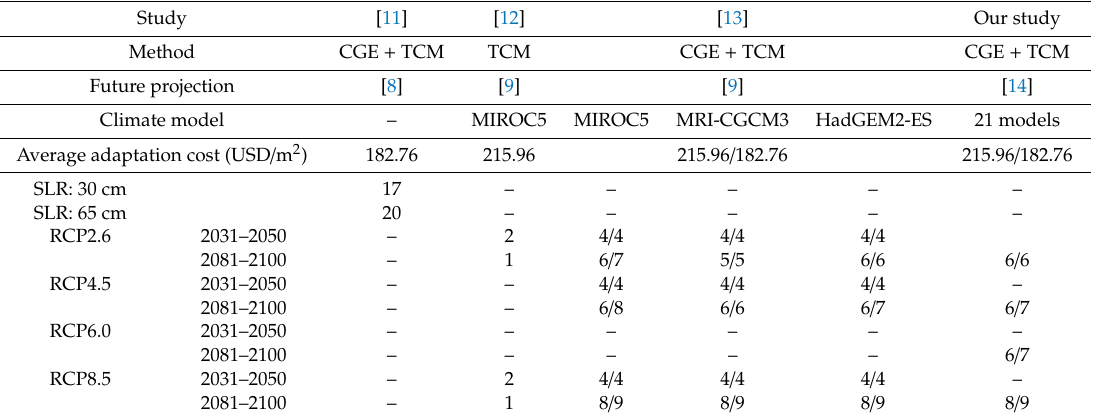
Table 7. Comparison with numbers of cost-e ff ective prefectures of earlier studies.